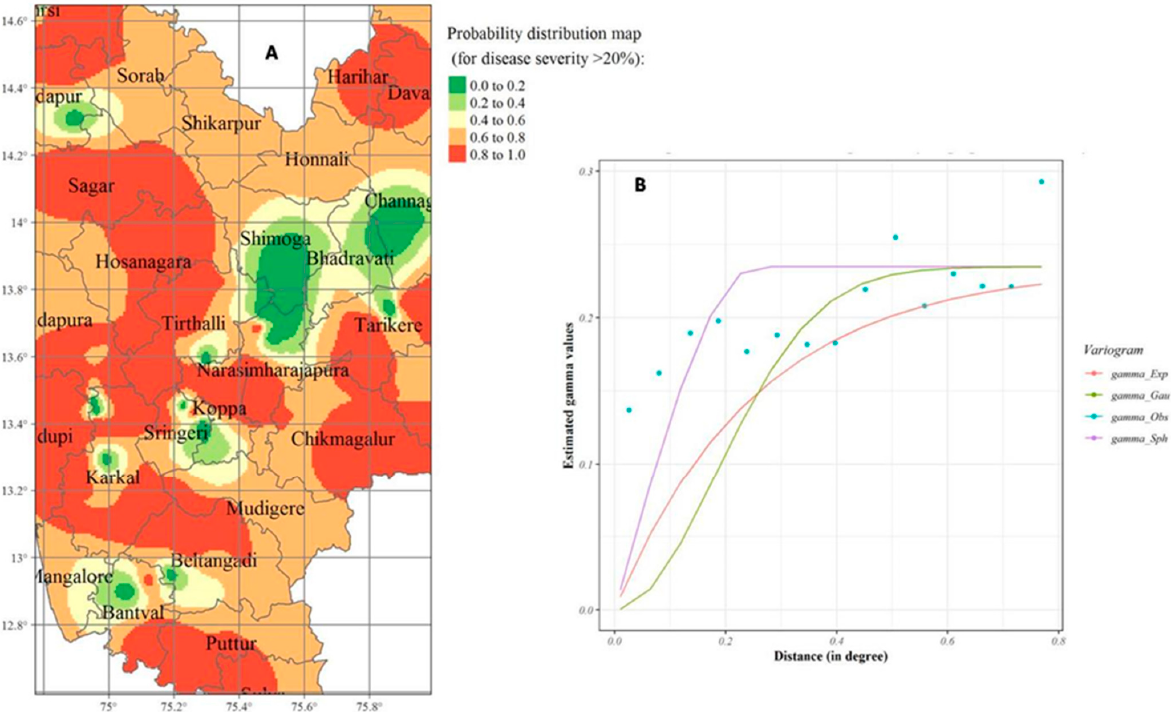
Figure 10. FRD probability distribution map for Karnataka ( A ) generated through semivariogram model information ( B ) using IK. The color-coded map (red to green) portrays the probability levels (high to low) of risk-prone areas infected with FRD.